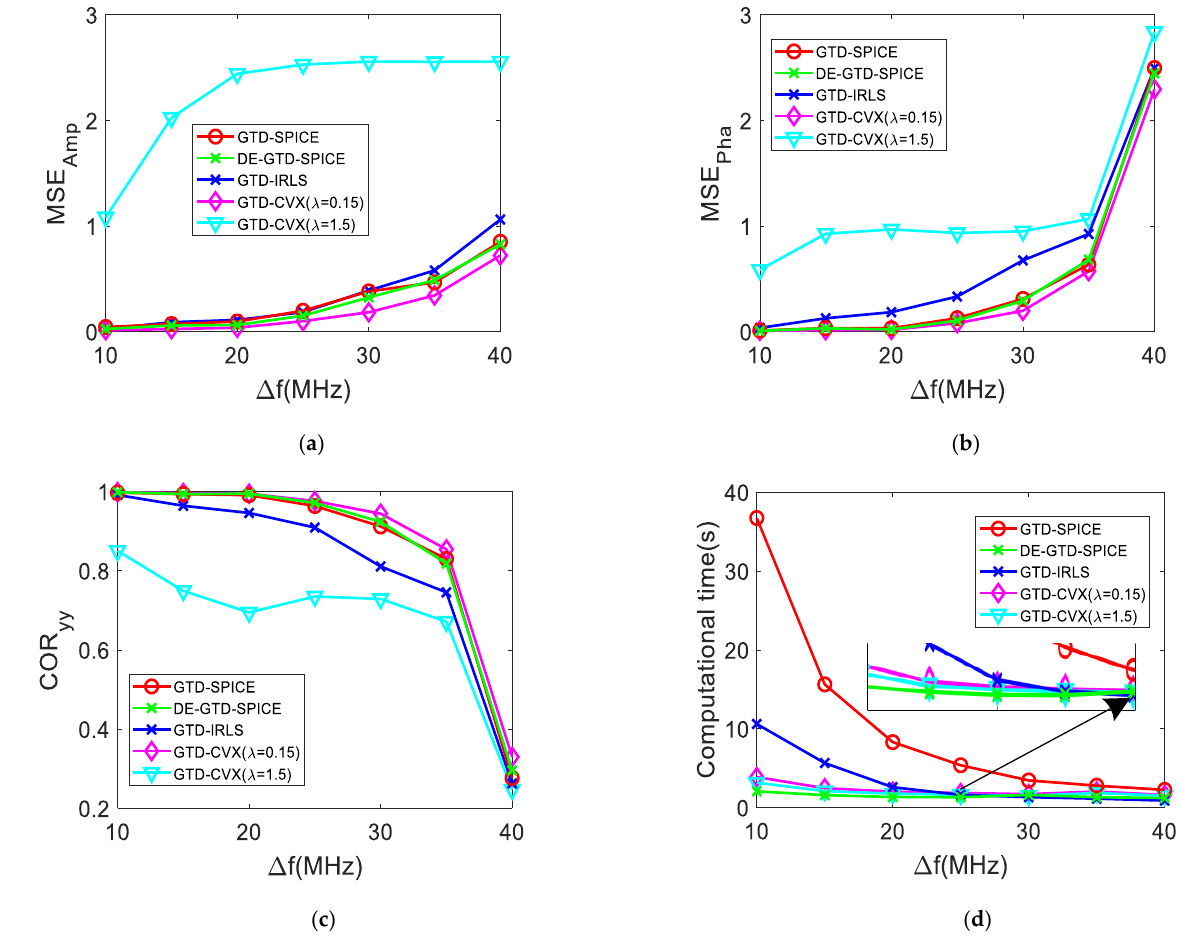
Figure 7. Comparison on ( a ) MSE of the amplitude of the reconstructed RCS sequence, ( b ) MSE of the phase of the reconstructed RCS sequence, and ( c ) the correlation coefficient versus the ∆ f . (d) Computational time versus ∆ f